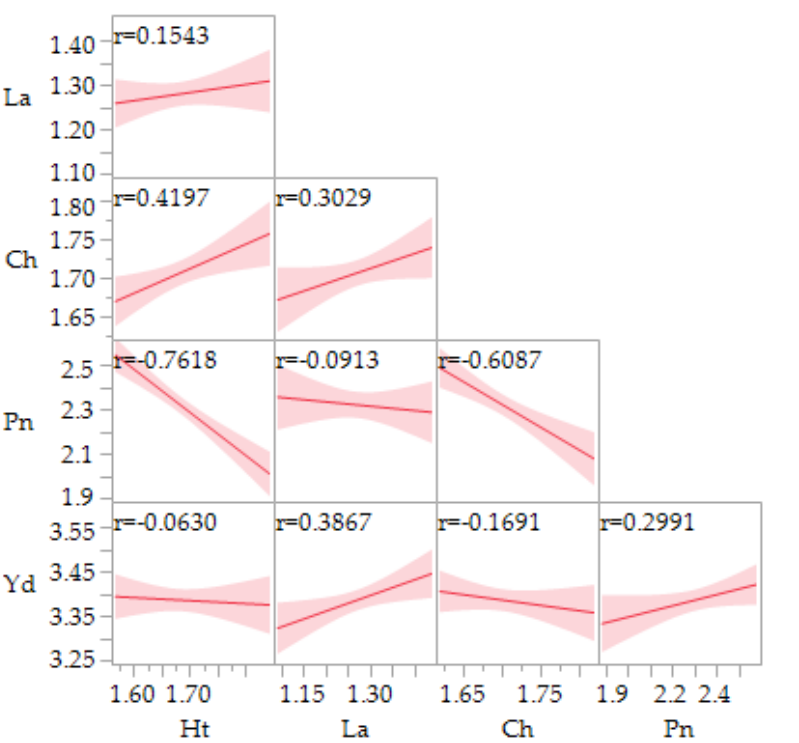
Figure 2. Correlation matrix of yield (Yd), plant height (Ht), leaf area (La), leaf chlorophyll content (Ch), number of plants per unit area (Pn), and for three varieties of quinoa grown in the high tunnel for leafy greens production in 2020, 2021 and 2022.